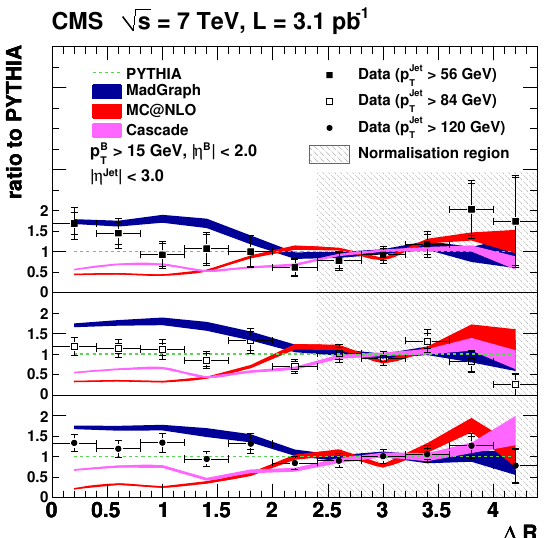
Fig. 3. Ratio of the di ff erential B hadron pair production cross Figure 8 . Ratio of the di↵erential BB production cross sections, as a function of  R (left) and   sections, as a function of ∆ R for data and various Monte Carlo generators with respect to the PYTHIA predictions, for three lead- (right), for data, MadGraph , mc@nlo and cascade , with respect to the pythia predictions, for ing jet p T regions. The simulation is normalised to the region the three leading jet p bins. The simulation is normalised to the region  R > 2 . 4 and   > 3 ∆ R > 2 . 4, as indicated by the shaded normalisation region. T (FCR region), as indicated by the shaded normalisation region. The widths of the theory bands indicate the statistical uncertainties of the simulation.